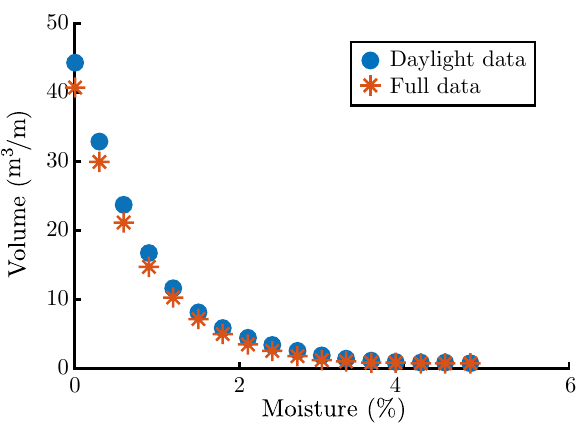
Figure 14. Comparison of volumes for different moisture values, obtained from the full wind data set and during daylight data (8:00–16:00), for the period 18 March 2009–11 March 2010.